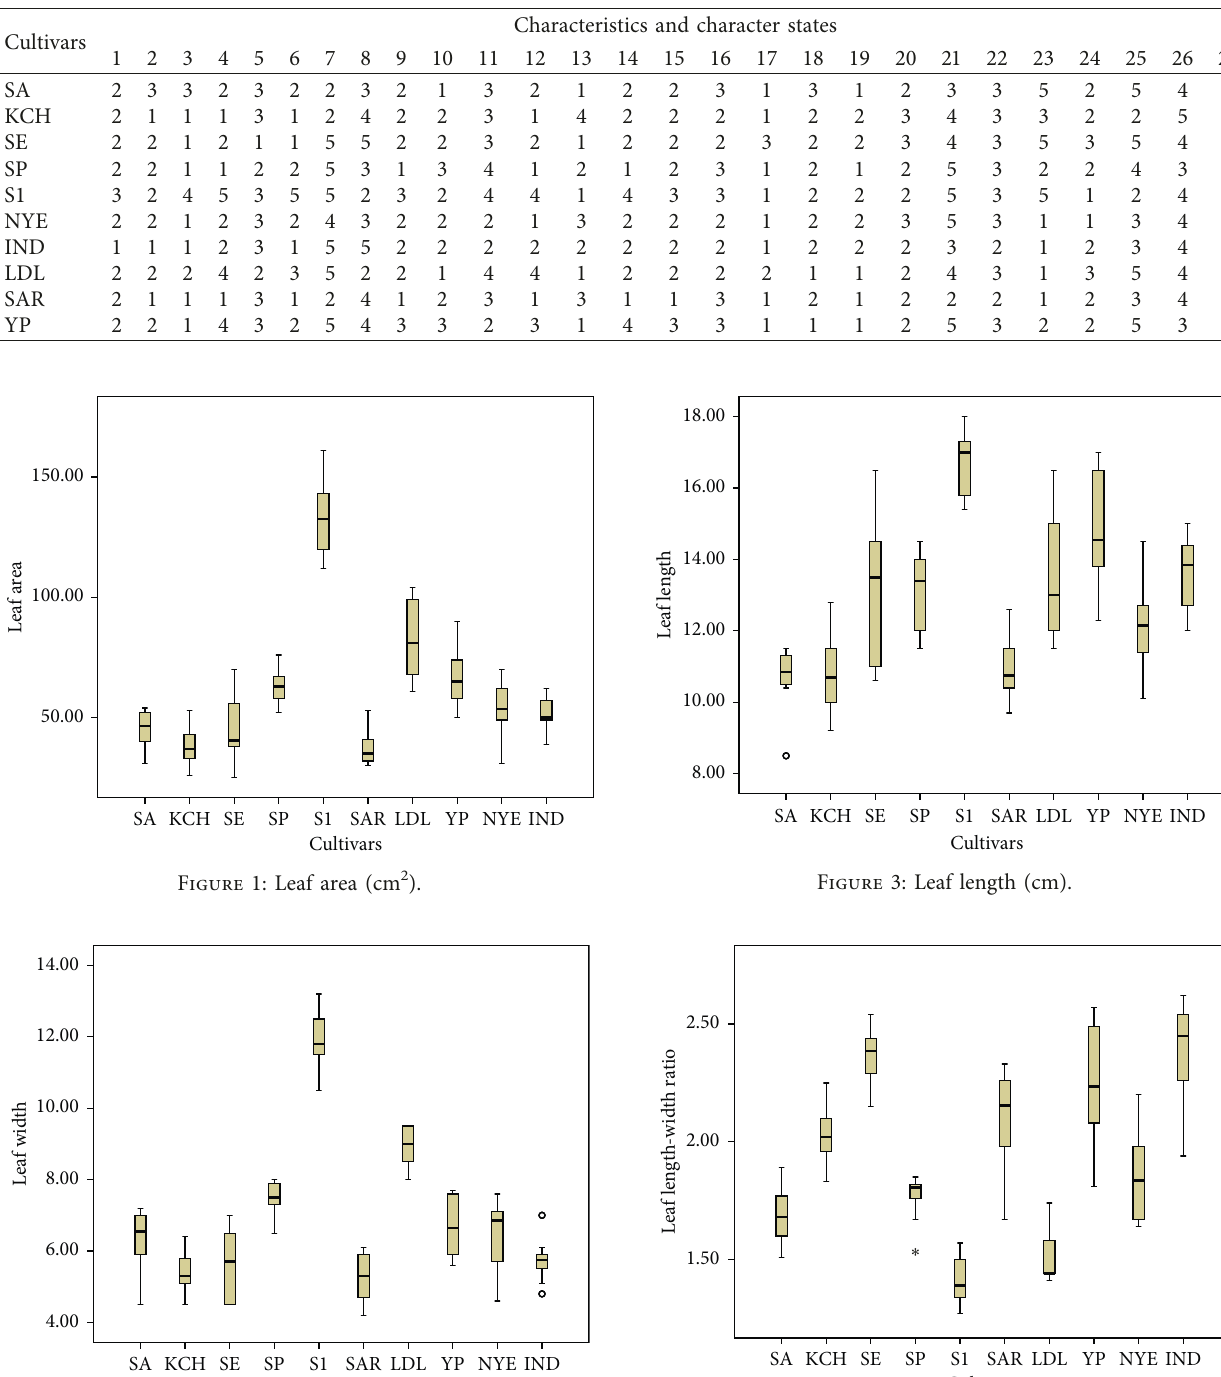
Table 3: Data matrix of phenetic character states corresponding to Table 1. Characteristics and character states Cultivars